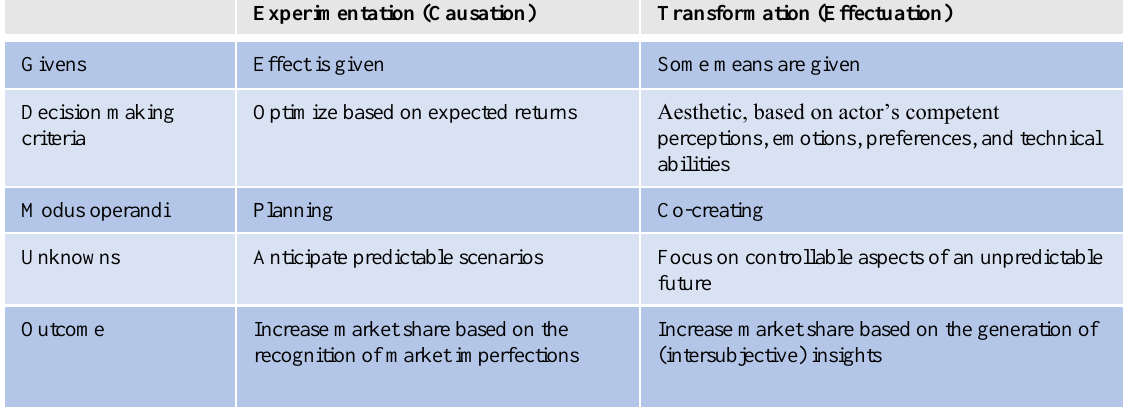
Table 1 . A comparison of experimentation and transformation based on Effectuation theory (adapted from Sarasvathy, 2001) Experimentation (Causation)